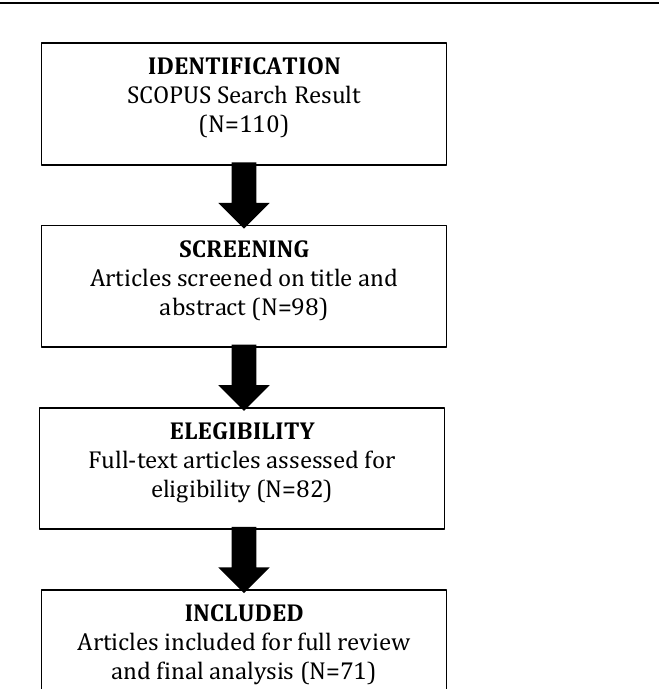
Figure 2. Preferred Reporting Items for Systematic Reviews and Meta-Analyses (PRISMA) flow